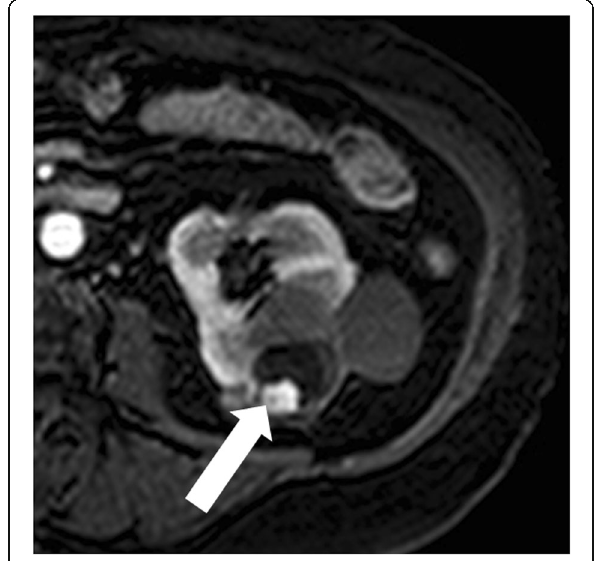
Fig. 8 Bosniak category III renal cyst. Axial contrast-enhanced T1- weighted MR image shows a lesion with thick, enhancing wall and septa (arrow)